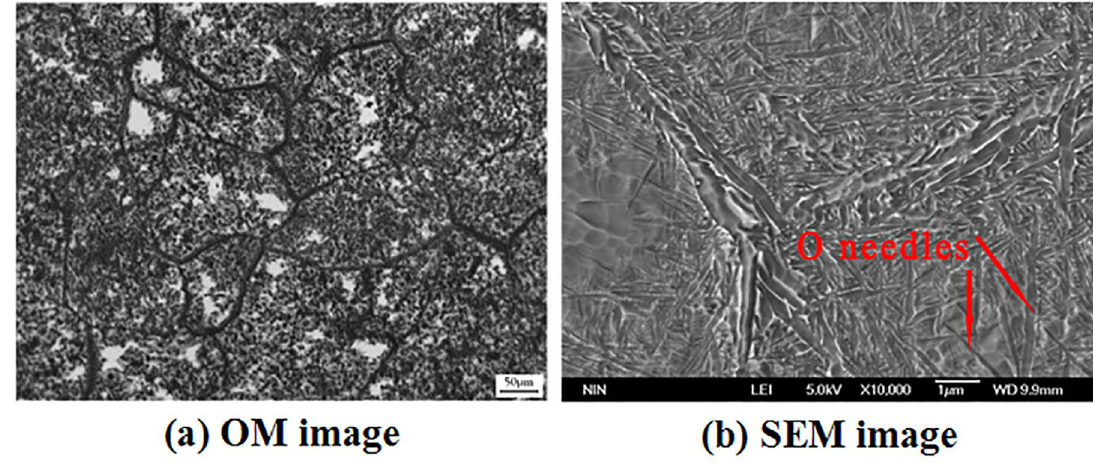
Figure 1. Microstructures of Ti-22Al-24Nb-3V-Y cast ingot.